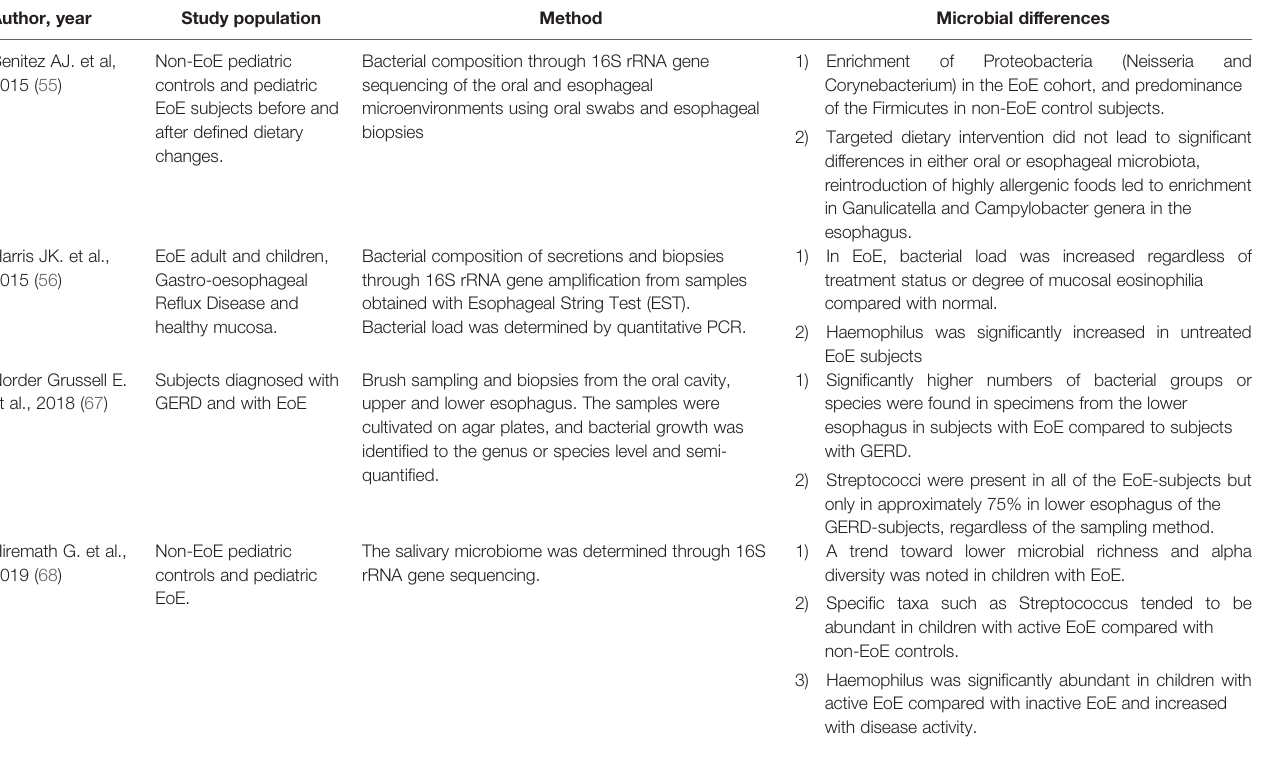
TABLE 1 | Main fi ndings about oesophageal Microbiota in